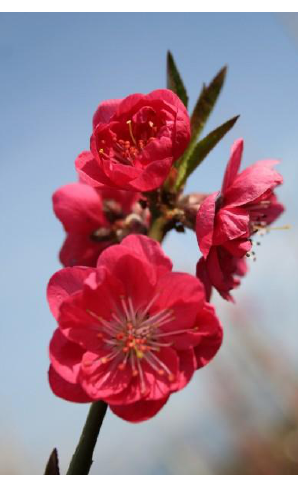
Figure 11. Ornamental peach twig Figure 12. Of purple leaf peach